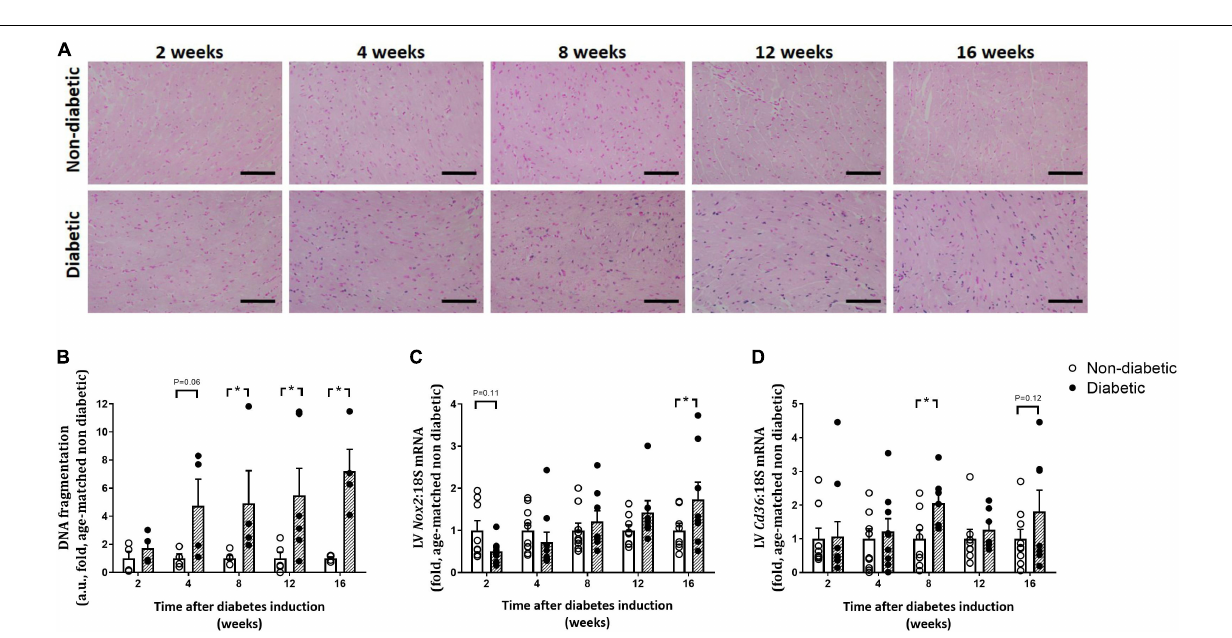
FIGURE 7 | Progression of other characteristics of the diabetic heart. DNA fragmentation (cardiomyocyte apoptosis), measured by CardioTACs as the percentage of blue positive-stained apoptotic cells to non-apoptotic negatively stained red cells, was increased from 4 weeks of diabetes (A,B) . Representative images for each endpoint are shown (A) . Scale bar = 40 µ m. LV gene expression of Nox2 was increased by 16 weeks (C) while gene expression of the fatty acid transporter Cd36 was increased from 8 weeks of diabetes (D) . Data are presented as mean ± SEM. * P < 0.05 vs age-matched non-diabetic mice (two-way ANOVA with Benjamini and Hochberg post hoc test). DNA fragmentation: n = 4–6/group; Nox2 and Cd36 gene expression: n = 7–10/group (refer to Supplementary Figure S1